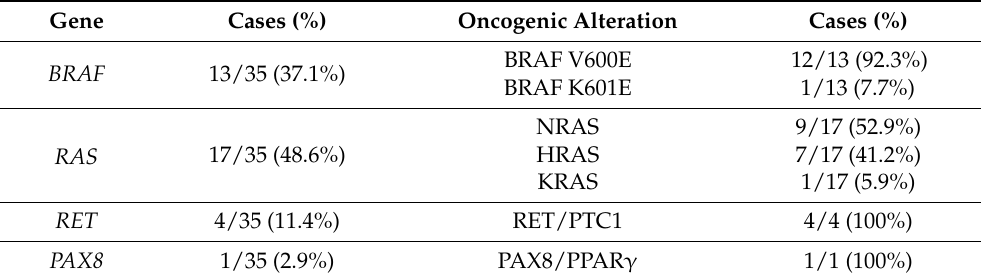
Table 1. Point mutations and rearrangements found in 35 cytological samples.